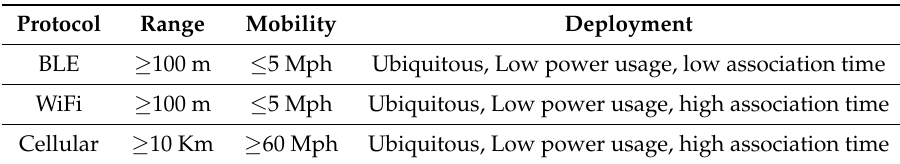
Table 1. RF transmission